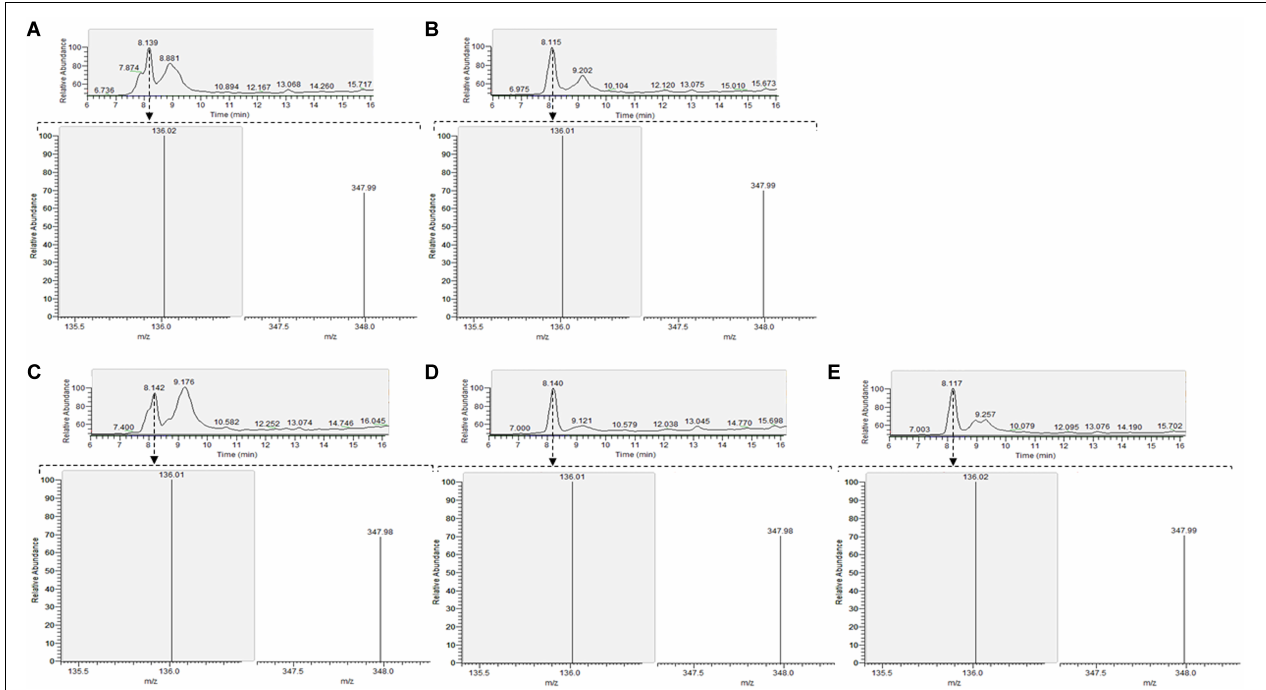
FIGURE 5 | Liquid chromatography–electrospray ionization/tandem-mass spectrometry (LC/ESI–MS/MS) chromatograms of peaks with cobalamin activity. The transitions are shown together (SRMs, 672.5 m/z – > 136.0 m/z calculated for adenine y 672.5 m/z – > 348.0 m/z correspond to the lower ligand in which adenine is the aglycon attached to ribofuranose 3-phosphate). Total ion chromatogram (TIC) of the active peaks of L. reuteri CRL 1098 ( A - CoCl 2 B - DMB + CoCl 2 ) and L. coryniformis CRL 1001 ( C - CoCl 2 D - DMB + CoCl 2 E - L -Thr + CoCl 2